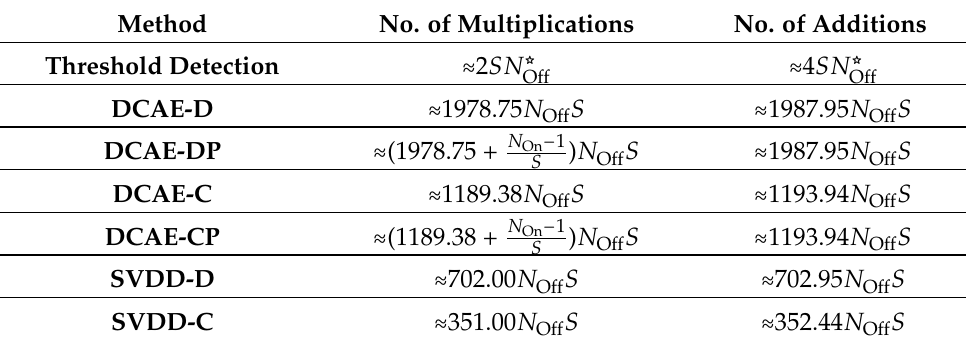
Table 5. Time complexity of the methods for each sample in the online phase. N Off and S are the training batch size and number of subcarriers,